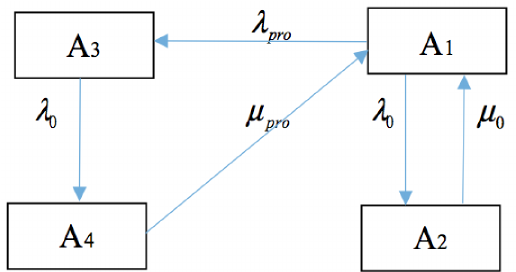
Figure 6. The multi-state Markov chain model to obtain the undesired-tripping